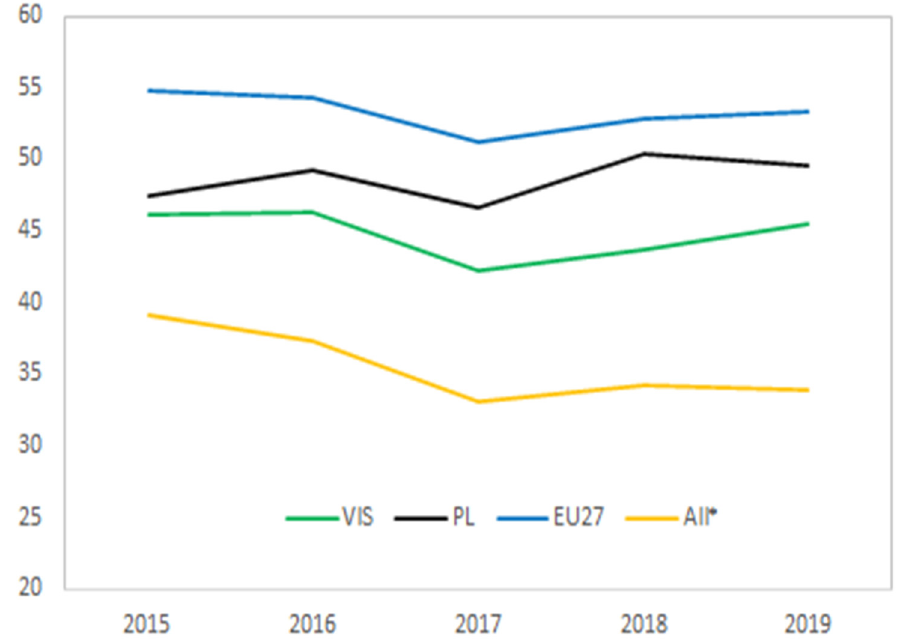
Figure 10. International Entrepreneurship Development Index (2015–2019). Source: GEDI [47].